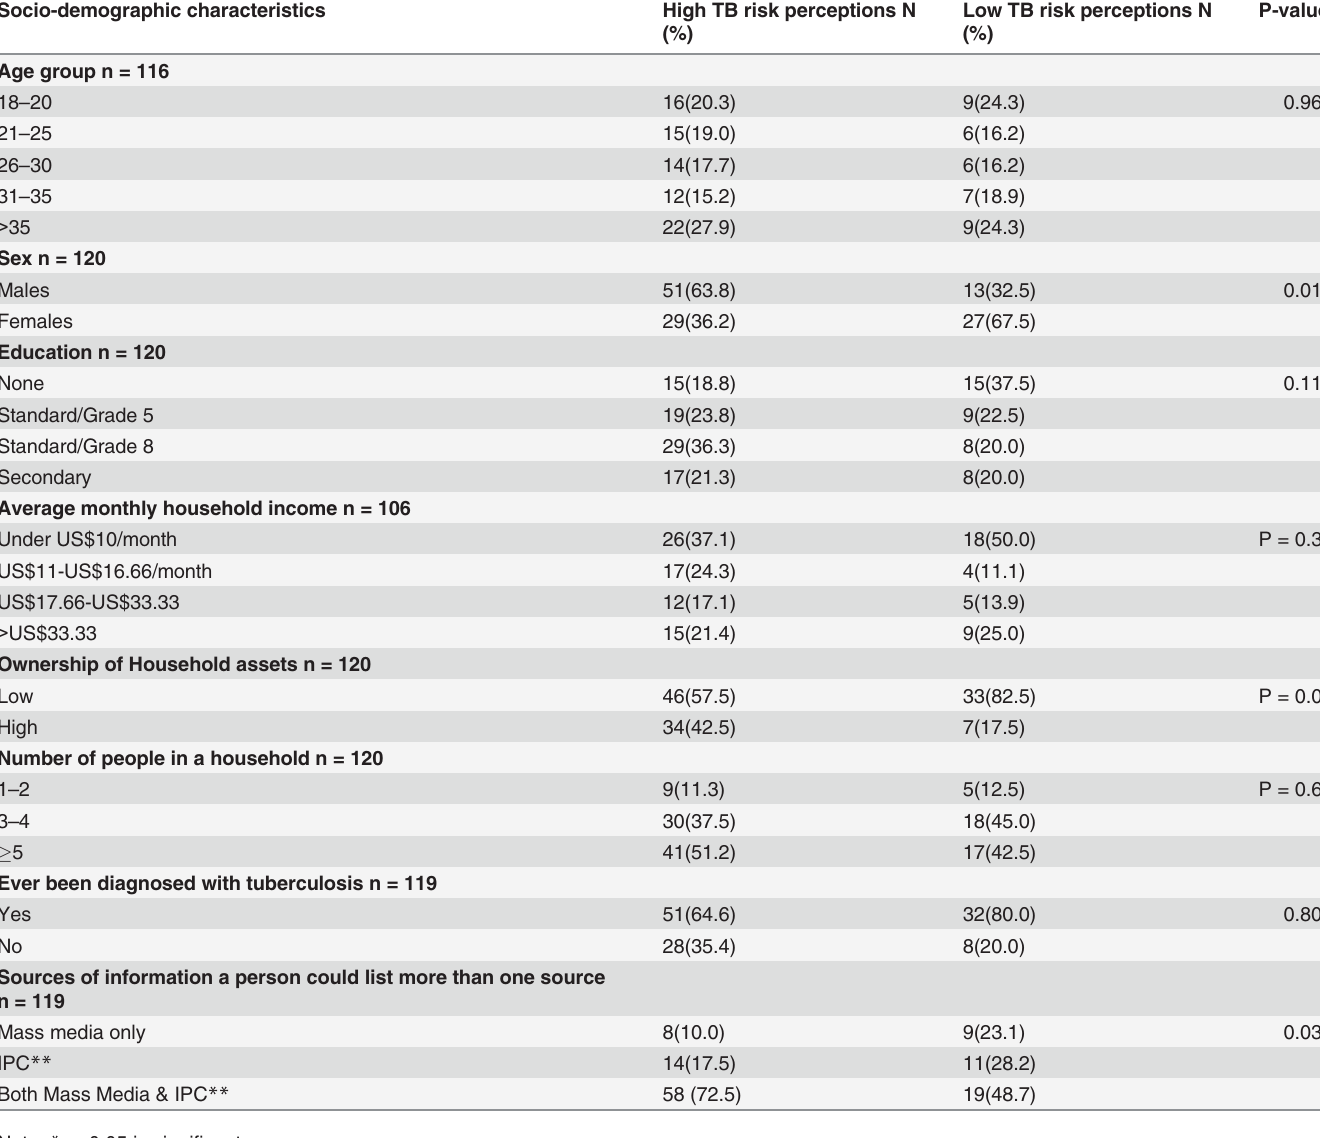
Table 2. Comparison of socio-demographic characteristic of participants by risk perception of